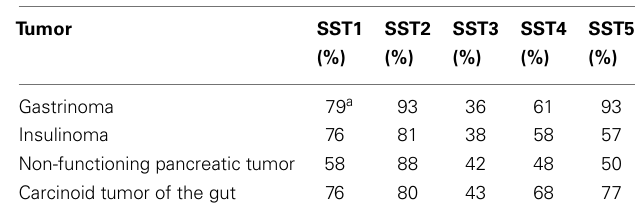
Table 1 | Somatostatin receptors a in neuroendocrine gastroenteropancreatic tumors (%).